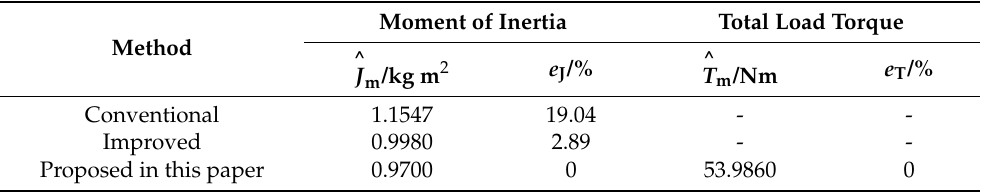
Table 3. Comparison of the simulation results of the identification value and identification